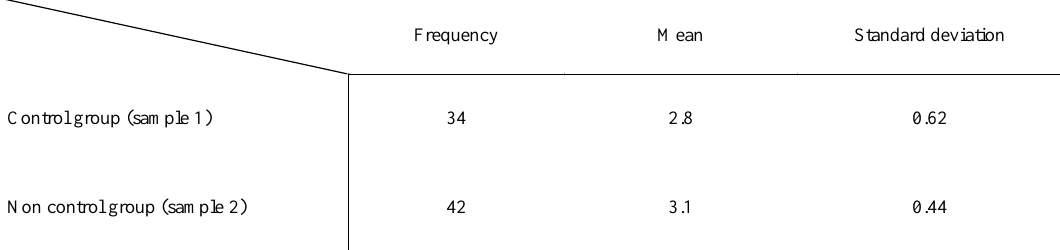
Table 2: Group statistics for exploration variable